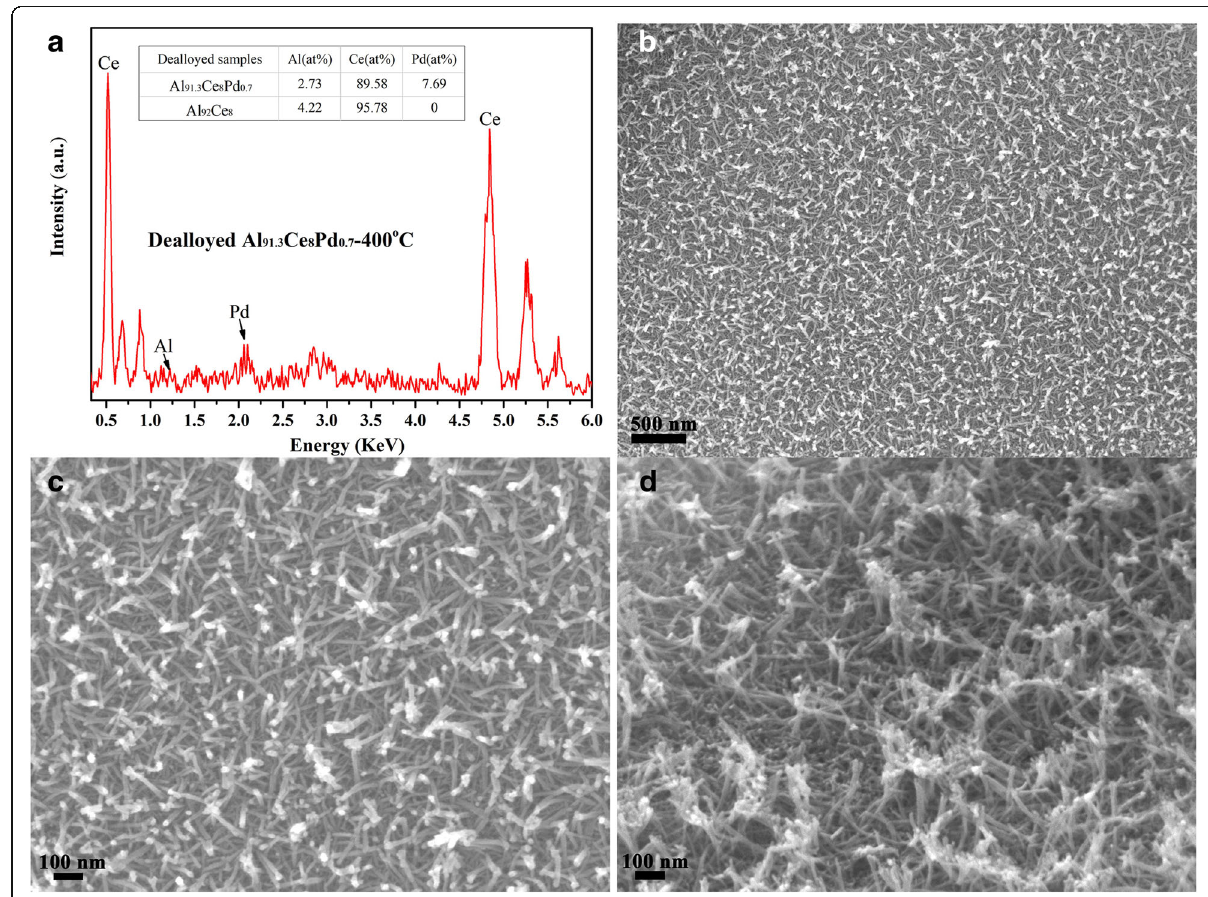
Fig. 3 EDS pattern ( a ), surface SEM images ( b , c ), and cross-sectional SEM image ( d ) of the dealloyed Al 91.3 Ce 8 Pd 0.7 alloy calcined at 400